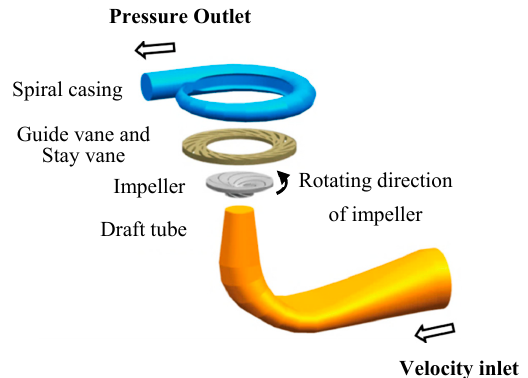
Figure 4. Computational Fluid Dynamics (CFD) computational domain (pump mode).